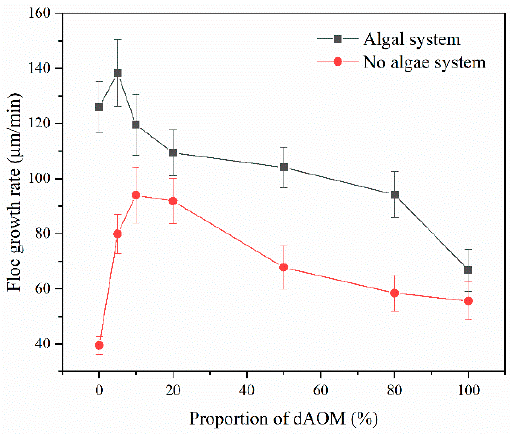
Figure 3. Growth rate of flocs in algal and non-algal systems at different dAOM concentrations.